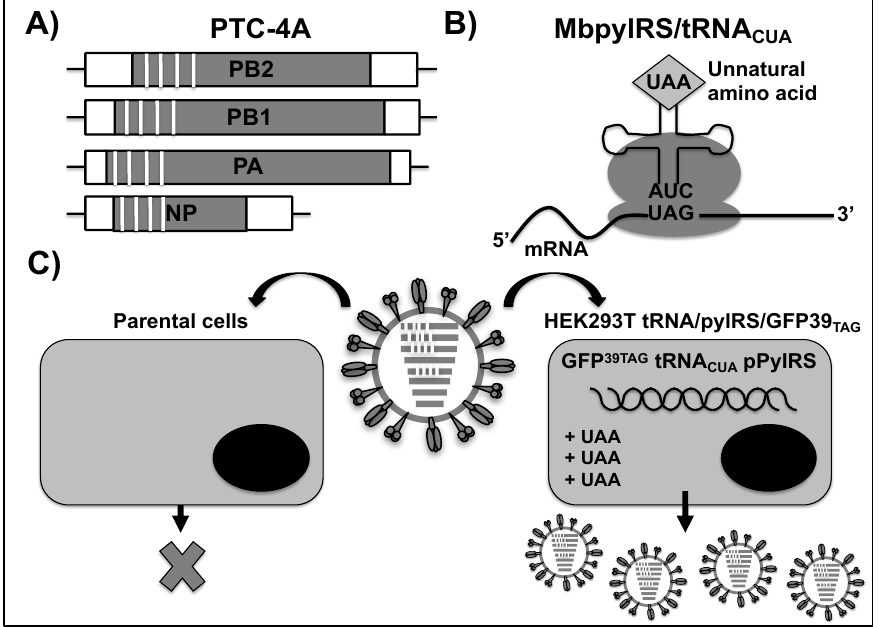
Figure 10. Generation of LAIV based on replication-incompetent viruses: ( A ) Introduction of premature termination codons (PTC) into the viral genome: IAV segments PB2, PB1, PA and NP containing four amber codon substitutions for the generation of replication-incompetent viruses are indicated. Packaging signals of each vRNAs located at 3’and 5’ ends are represented in white boxes. Lines at the end of each vRNA indicate the 3’and 5’ NCR. ( B ) Schematic representation of the orthogonal translation system: Schematic representation of ribosomal incorporation of the orthogonal unnatural amino acid (UAA) and the UAA-tRNA recruitment during the translational elongation event. An UAA is charged onto a tRNA with the required non-sense anticodon by an orthogonal tRNA synthetase. This tRNA then recognizes its corresponding mRNA non-sense codon in the ribosome, leading to the incorporation of the UAA into the protein of interest. ( C ) Establishment of a virion packaging system compatible with the orthogonal translation machinery: Generation of premature termination codon (PTC) viruses are characterized by replication incompetence in conventional cells (left) but efficient replication in cells that contain the cassettes for the expression of orthogonal tRNA (tRNA CUA ), tRNA synthase (pylRS), and a gene encoding an amber codon–containing GFP (GFP 39TAG ), leading to viral production (right).